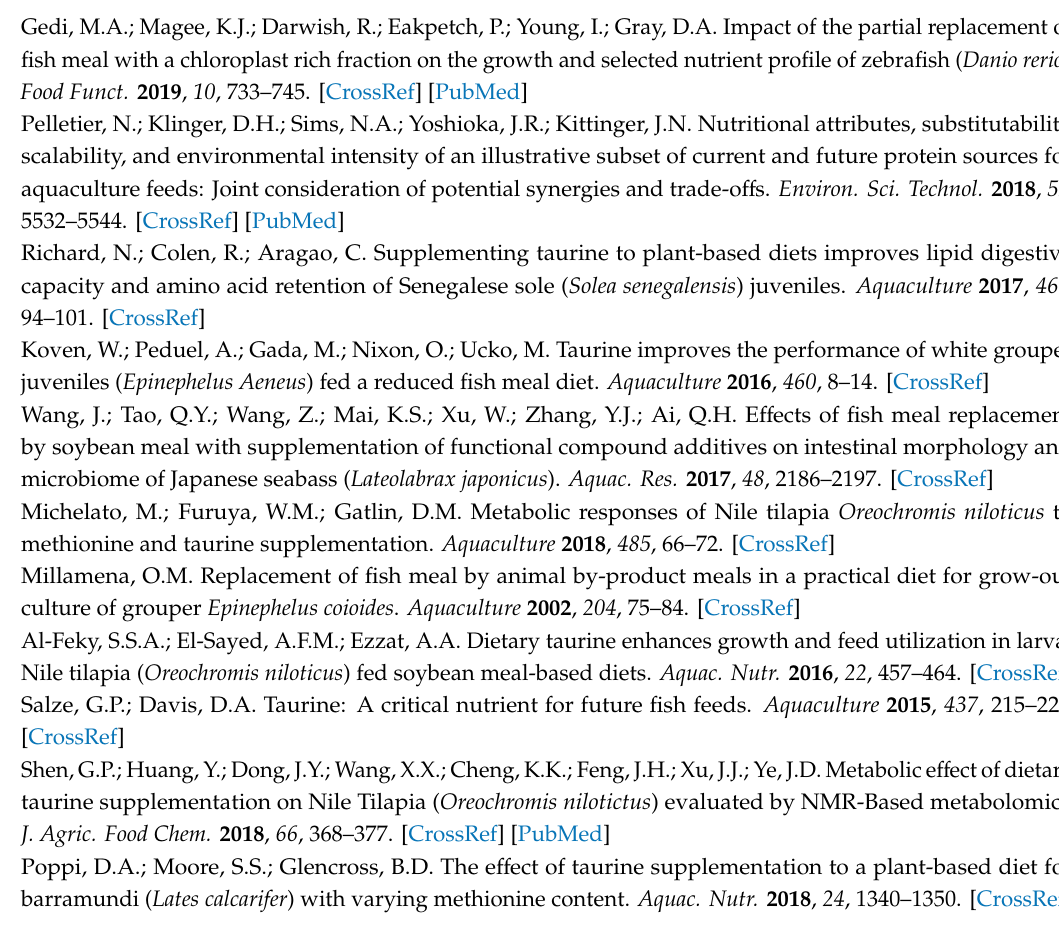
Supplementary Materials: The following are available online, Figure S1: PLS-DA scores plots (left panel) and validate model plots (right panel) by permutation tests ( n = 200) for 1H NMR spectra of grouper intestine between di ff erent taurine-supplemented groups at FD84. (A) D1-D2; (B) D1-D3; (C) D1-D4; (D) D2-D3; (E) D2-D4; (F) D3-D4, Table S1: Ingredients and composition of experimental diets (on an as fed basis), Table S2: Metabolites identified from NMR spectra of grouper intestine and the corresponding assignments, Table S3: Relative concentration value (Mean ± SD) of di ff erent metabolites by the calculation of characteristic peaks during the 84 days feeding trail. Excel file: Raw data used for multivariate